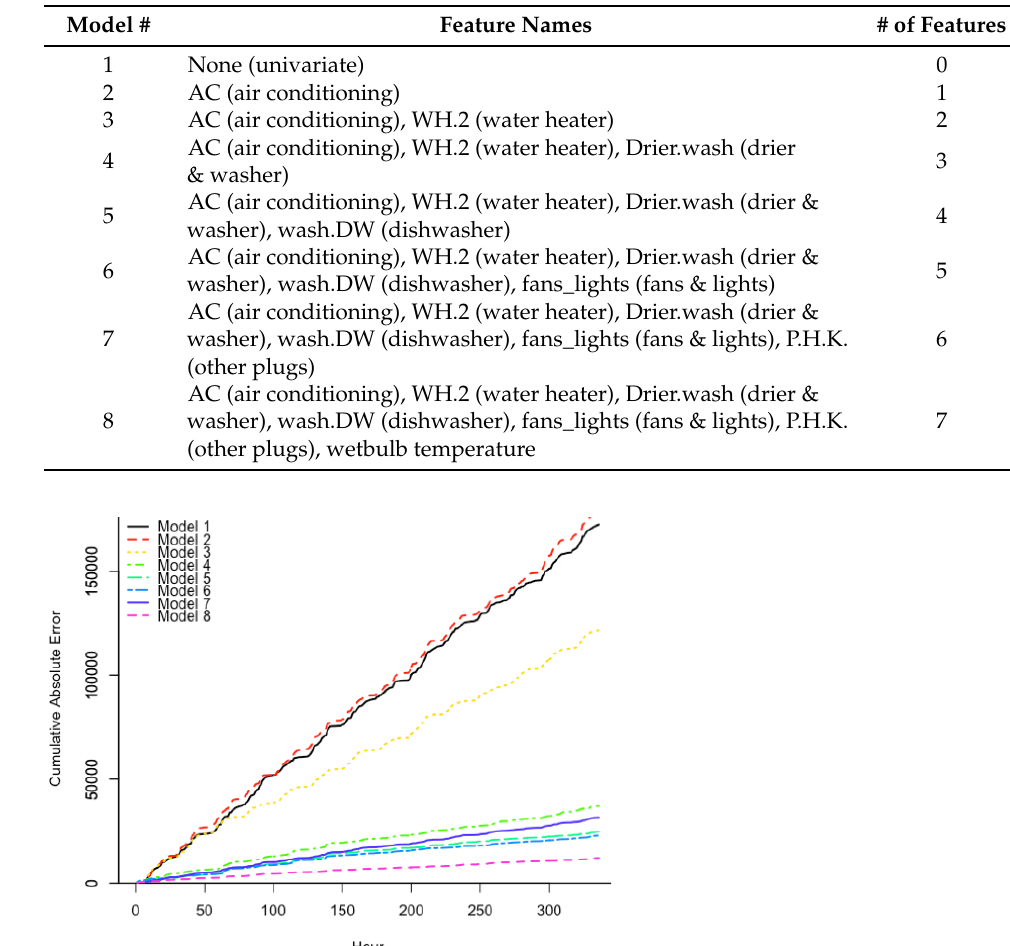
Table 1. The models created and their included features (i.e., submeters) for application 2 that correspond to Figures 4 and 5.